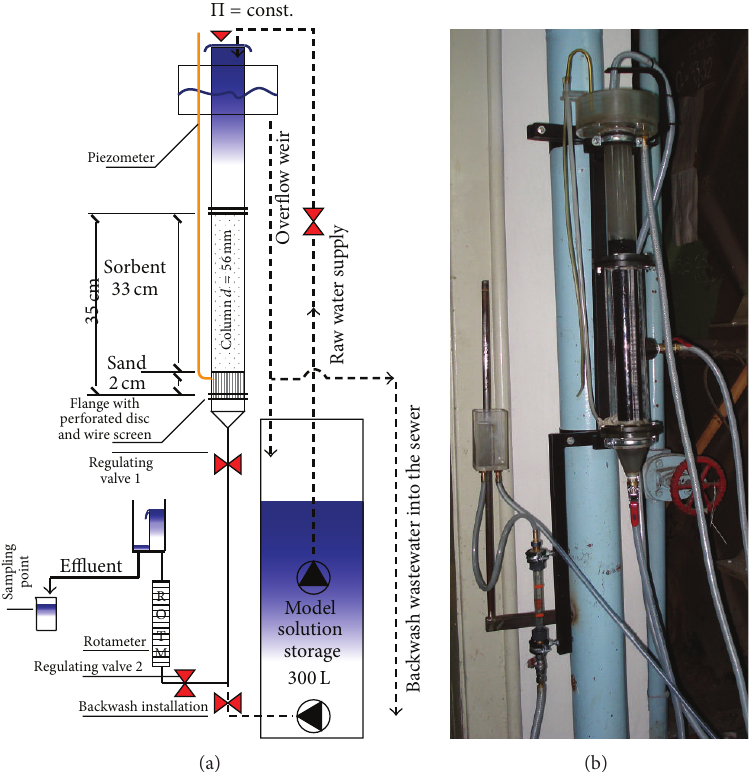
Figure 1: Experimental setup: pilot model of the sorption-filtration column for the arsenic removal from water.